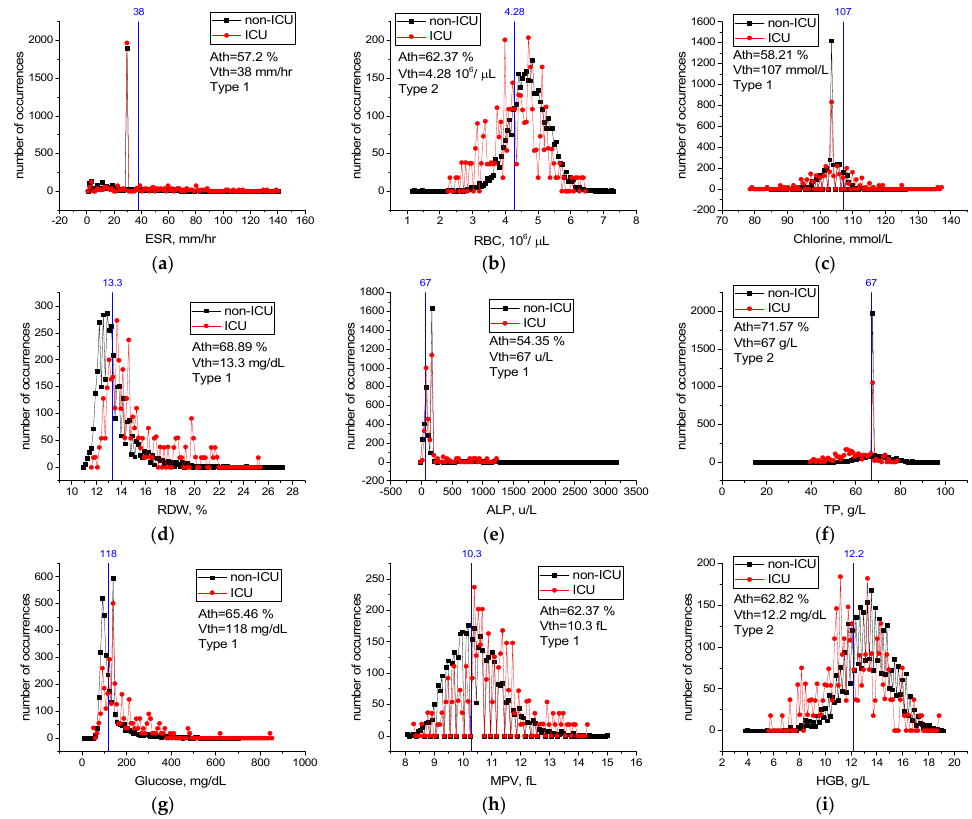
Figure 10. Case distribution histograms for ESR ( a ), RBC ( b ), Chlorine ( c ), RDW ( d ), ALP ( e ), TP ( f ), Glucose ( g ), MPV ( h ), HGB ( i ) from mildly and severely infected COVID-19 patients and the threshold values Vth of these features (blue line) in the prognosis of the disease. Histogram bin sizes are listed in Table